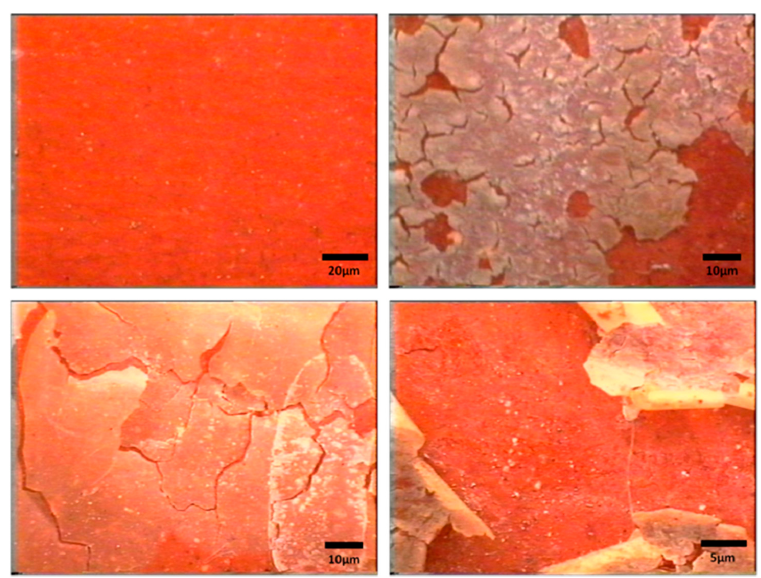
Figure 20. Digital microscopy images displaying the different preservation states of the protective coating applied on the plastered surfaces.